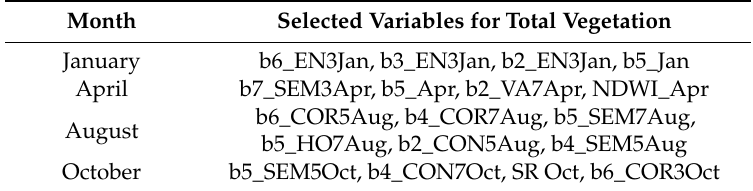
Table 4. The selected variables for AGB estimation models for di ff erent months based on the total vegetation. Month Selected Variables for Total Vegetation